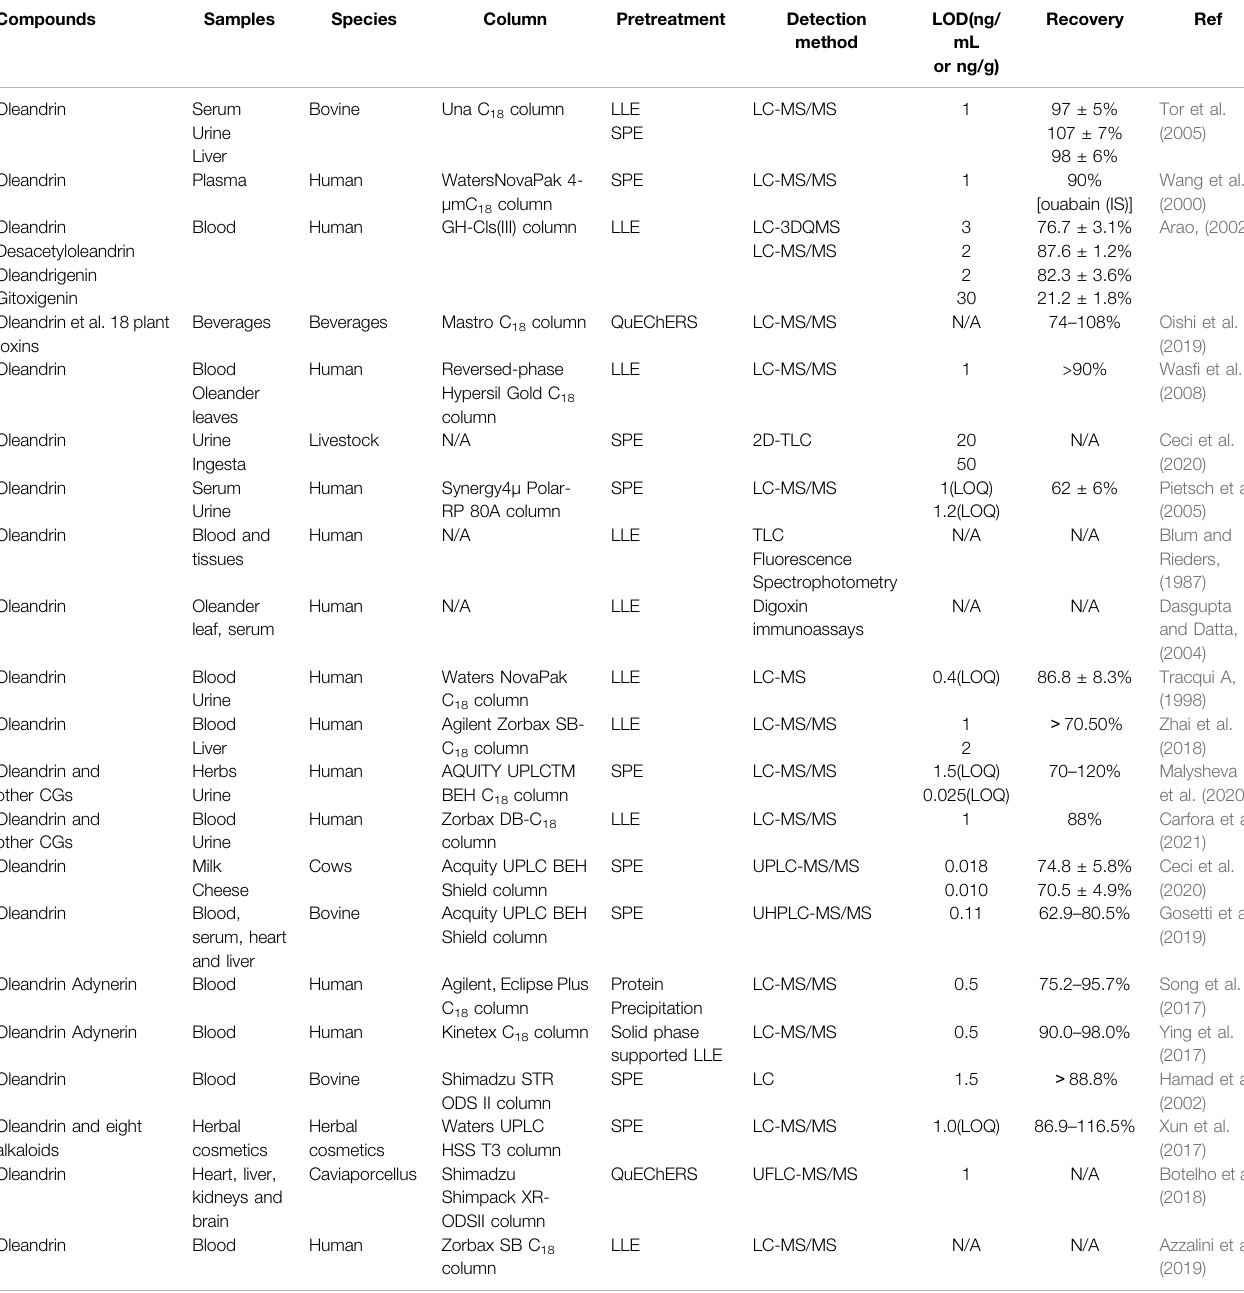
TABLE 1 | Summary of oleandrin detection